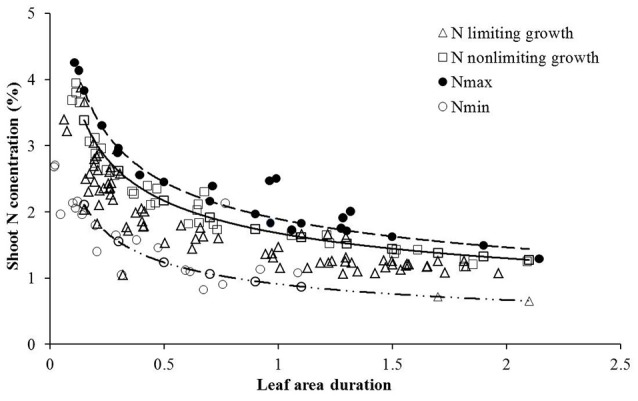
Validation of the Nc dilution curves for winter wheat. Data points (Δ) represent N limiting condition, (□) represent non-N-limiting condition. The solid line indicates the Nc curves (Nc = 1.6774 LAID–0.37, while the dashed lines represent the minimum and maximum N curves respectively, (Nmin = 0.9089 LAD−0.444, Nmax = 1.8934 LAD−0.372). The (•) points represent N concentration from highest N rate and the (°) points are from zero N rate obtained from Experiments 2 and 4.